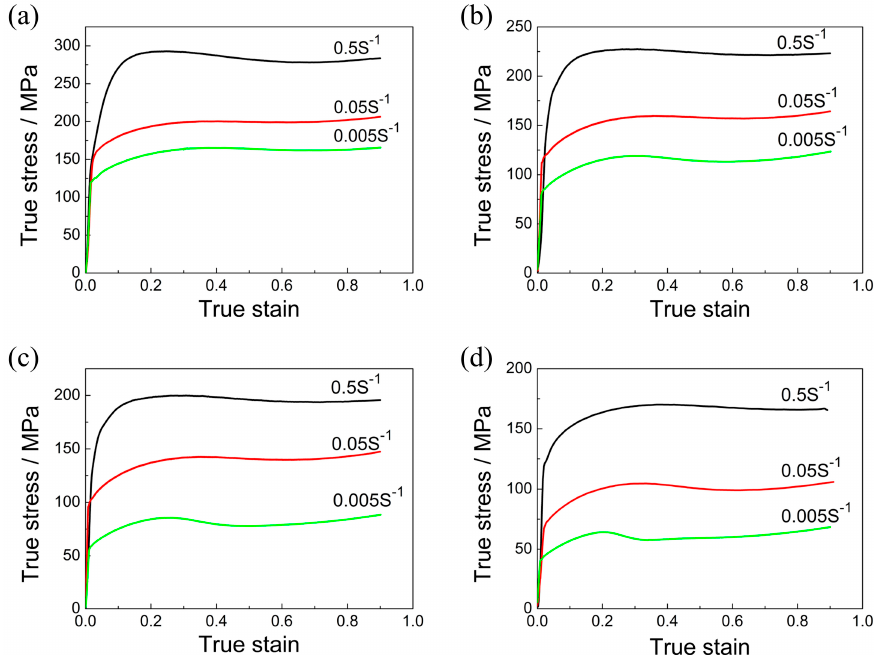
Figure 1. Compressive stress-strain curves of FeMnSiCrNi SMA undergoing compression: ( a ) T = 850 °C; ( b ) T = 900 °C; ( c ) T = 950 °C; ( d ) T = 1000 °C.